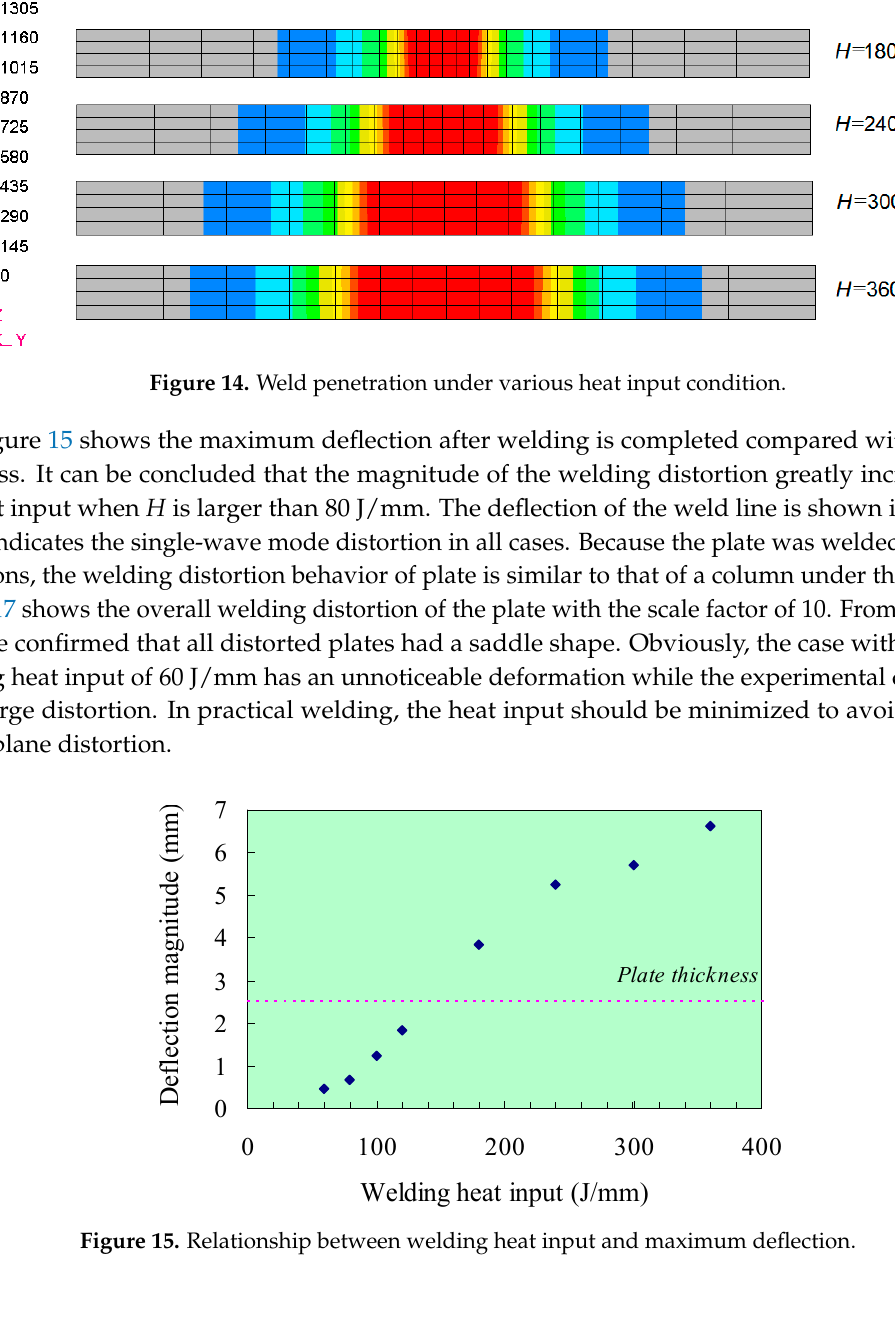
Figure 16. Deflection profile along the weld line. Figure 17. Welding distortion under various heat input condition (scale factor is 10).